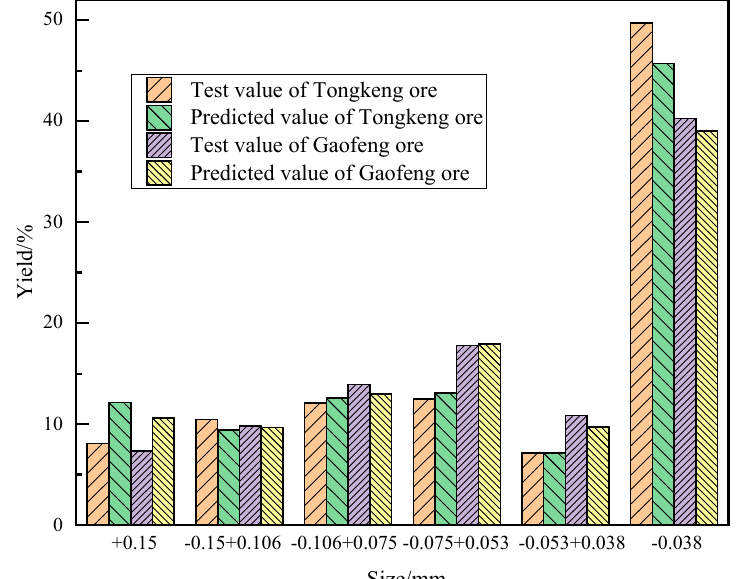
Figure 8. Prediction results of B III method for Tongkeng ore and Gaofeng ore. It can be seen from Figure 8 that the prediction error of the two ores by the B III method Table 8. Error comparison of Tongkeng ore and Gaofeng ore.